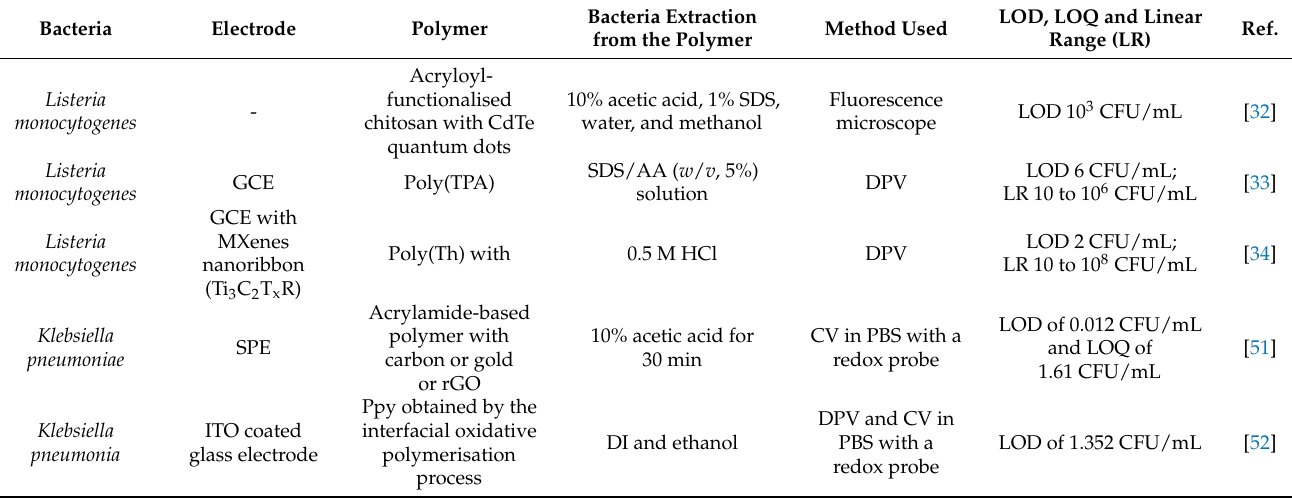
Table 2. Summary of the MIP-based sensors for Listeria monocytogenes and other